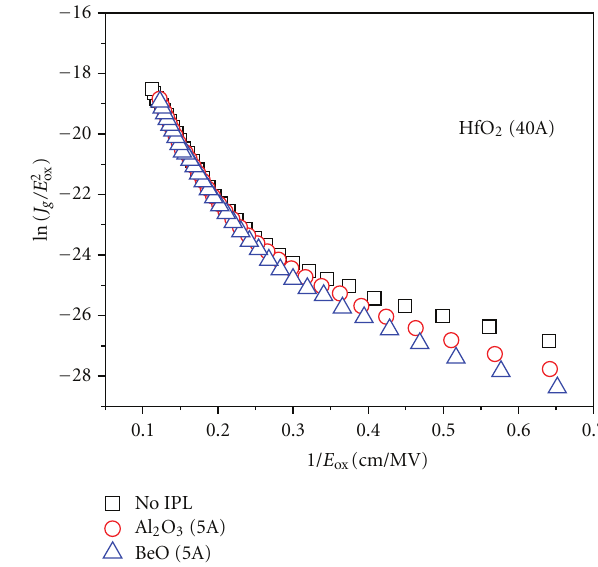
Figure 4: F-N plots to compare the e ff ective potential barrier height for three di ff erent gate stacks.